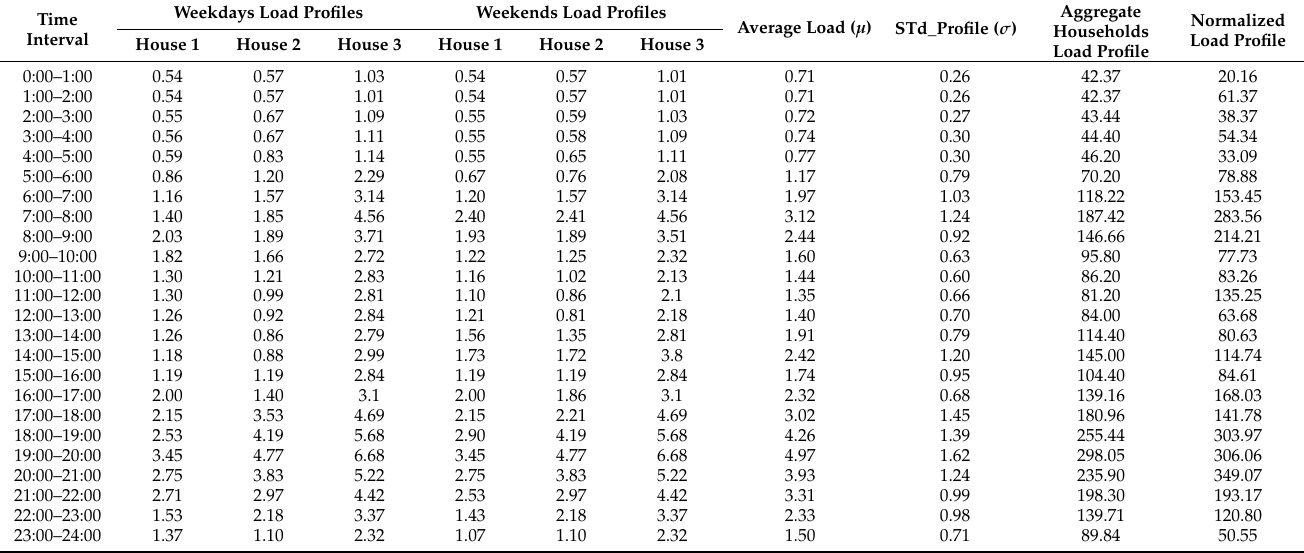
Table A1. Typical residential summer load profiles (kWh) in Pretoria, South Africa. Time